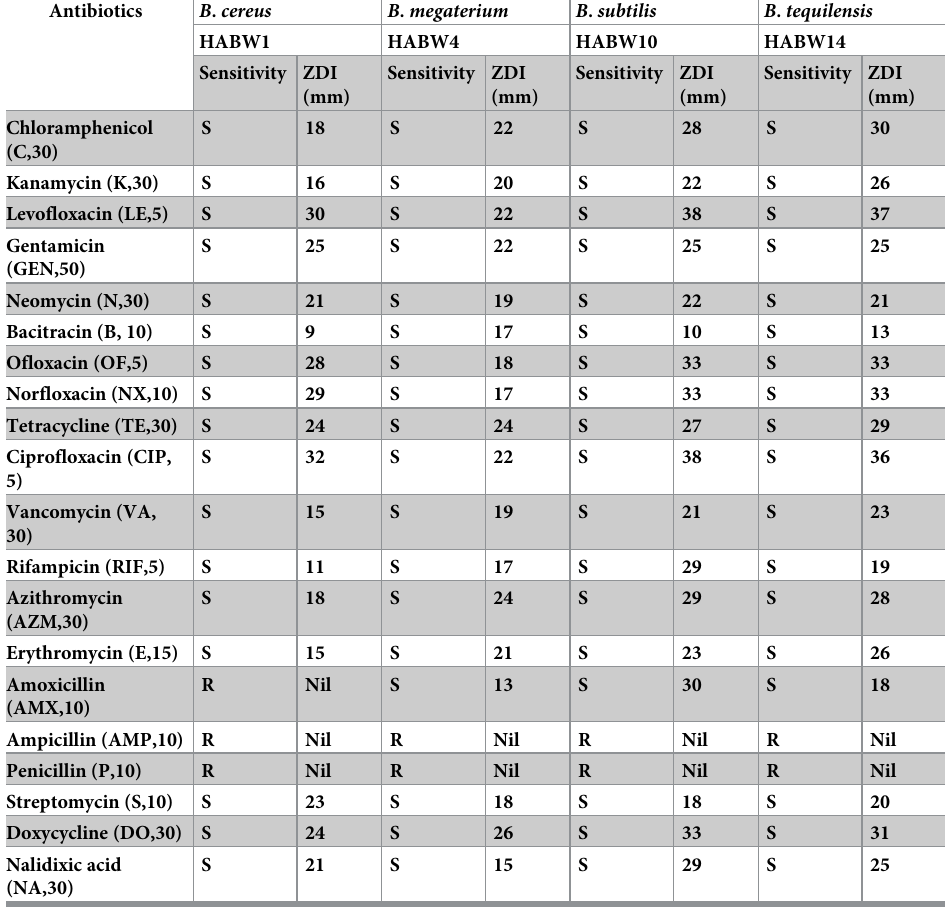
Table 10. Antibiotic sensitivity of oviposition attractant bacteria of Anopheles subpictus .